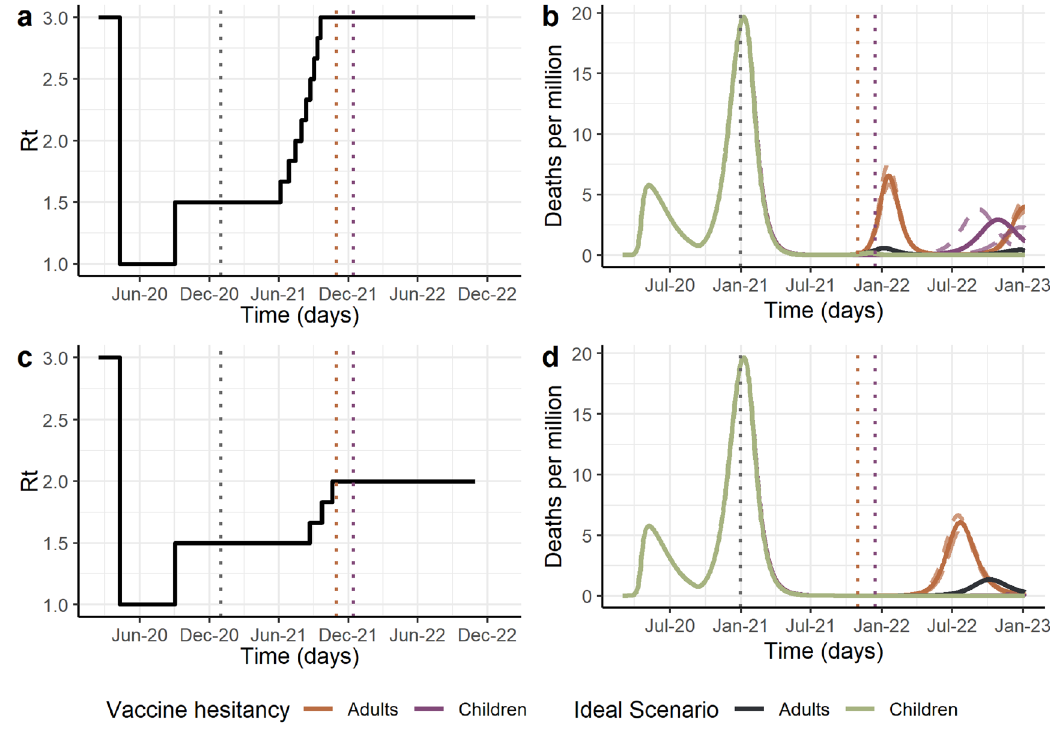
Fig. 1 Projected COVID-19 dynamics given vaccine hesitancy. Panels a , b show a high vaccine ef fi cacy (94% against infection, 98% against hospitalisation and death), panels c , d moderate vaccine ef fi cacy (63% against infection, 85% against hospitalisation and death). Panels a and c show the reproductive number Rt pro fi le, which represents the level of NPI stringency, with lower numbers indicating higher stringency. In this illustrative example, we assume that a fi rst wave of transmission occurred at the beginning of 2020 with the assumed value of Ro: 3. This was followed by NPIs leading to a reduction in Rt to 1, followed by an Rt of 1.5 as NPIs are lifted leading to a second wave of transmission in the latter half of 2020. After vaccination is introduced at the beginning of 2021, NPIs in all scenarios are lifted according to a schedule based on coverage under the ideal scenario (no vaccine hesitancy, 95% of individuals 15 years plus are vaccinated). Panels b and d show projected deaths per million under vaccine hesitancy scenarios: adults- only vaccination (orange), vaccination including children (purple). Continuous lines represent simulations of median vaccine coverage per age group, while dashed lines represent simulation of 10% and 90% quantiles. For the ideal scenario black line represents adults-only vaccination and green line represents ideal scenario when children vaccination is considered. In each scenario, fi nal vaccination coverage per age group and deaths vary according to vaccine hesitancy. Vertical dashed lines indicate the vaccination rollout period in the ideal